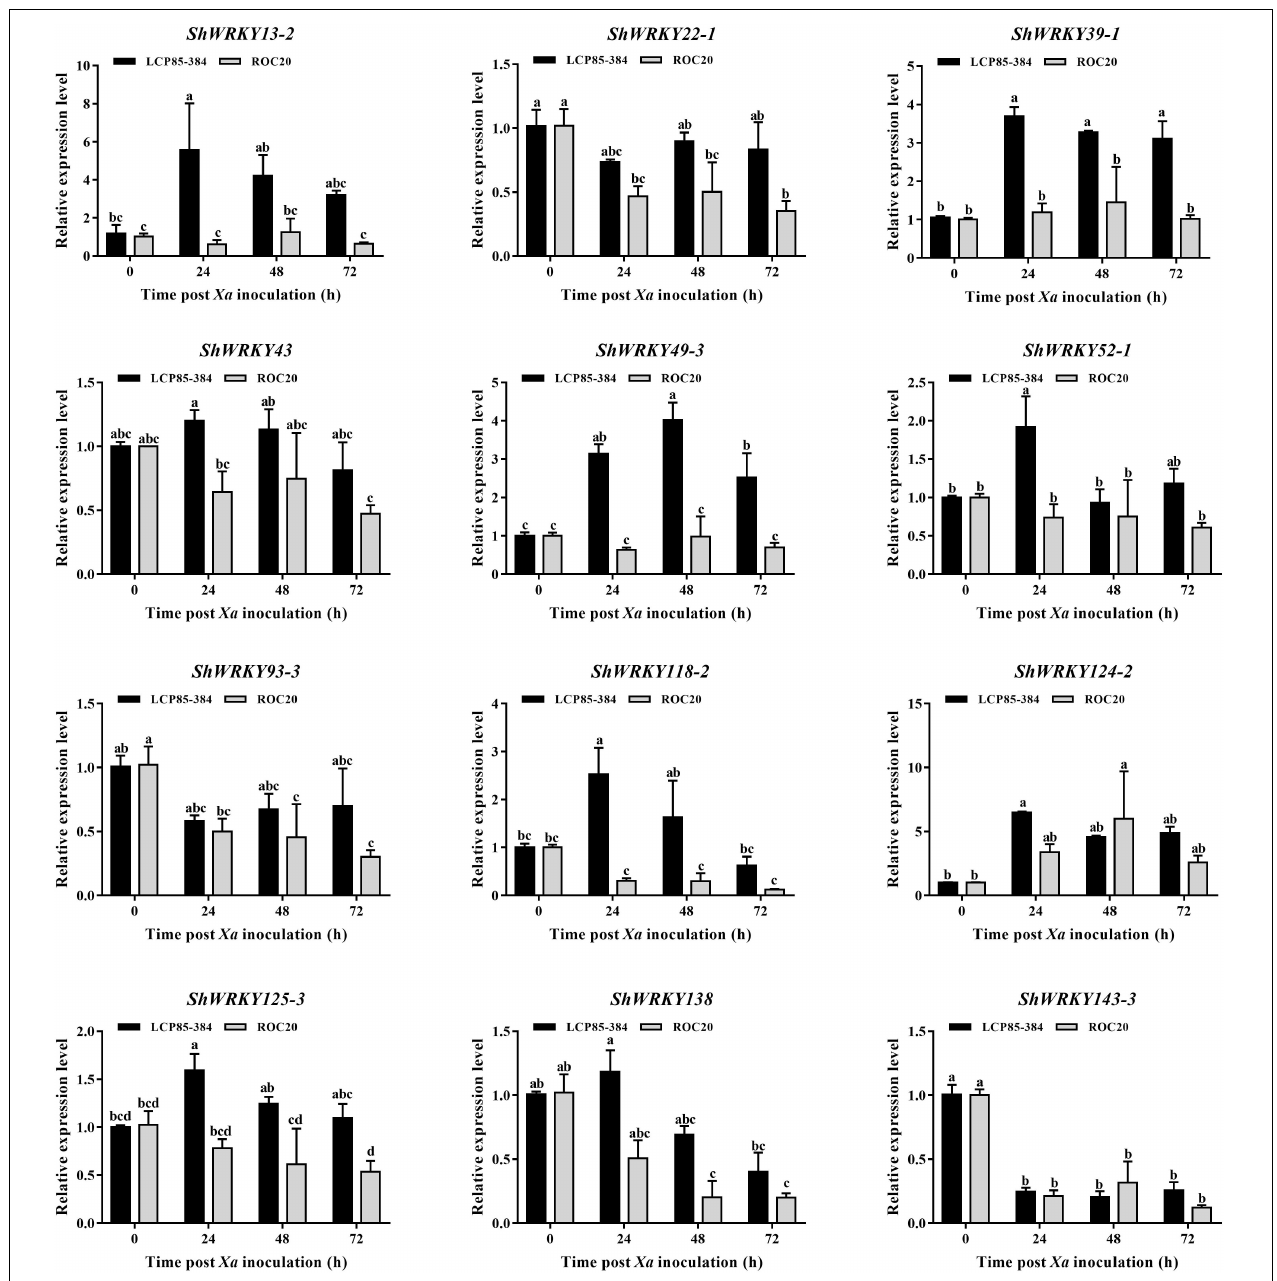
FIGURE 5 | Expression profiling of twelve ShWRKY genes at different times post- Xa inoculation in LCP85-384 (black gars) and ROC20 (gray bars) cultivars. Values for relative expression levels are means ± standard errors. Means having the same letters above the vertical bars are not significantly different at a 5% level of probability.